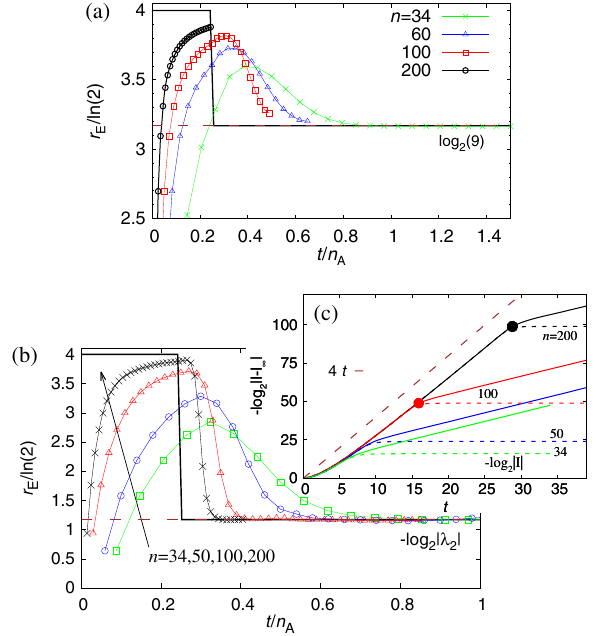
FIG. 7. Local entanglement rate r for the BW configuration E 0 (the XY gate), and (b) and (c) with PBC. Panel (a) is for a z ¼ 0 . 5 . The full black line in panel (a) is a conjectured are for a z ¼ r in the TDL, which has a discontinuous jump from 4 for t ≤ E t t λ ∞ to a smaller value given by 2 . In panel (c), dotted curves c ¼ are − log 2 I ð t Þ and full curves − log 2 j I ð t Þ − I ∞ j , while the transition times t for n ¼ 100 and 200 are marked by full c circles. The dashed brown line in panels (a) and (b) agrees with − log λ 2 j from Fig. 2 j